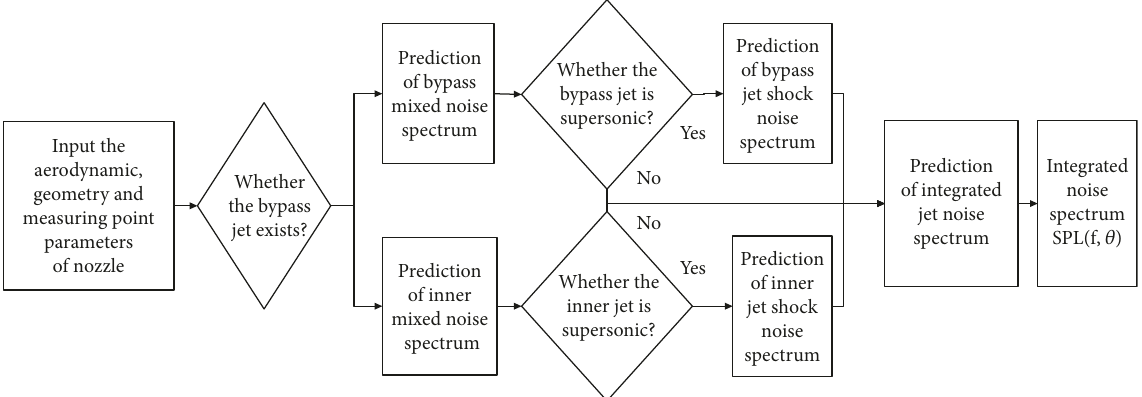
Figure 14: Prediction fl ow chart of the jet noise